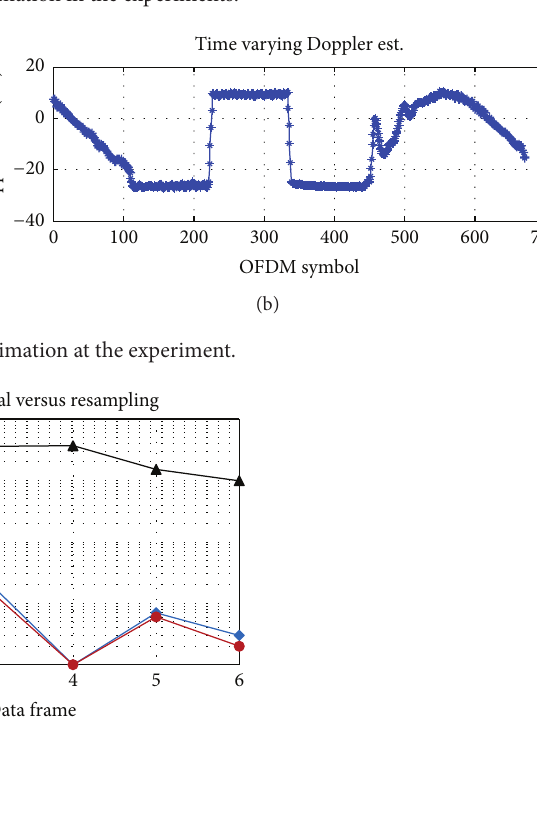
Figure 13: 16QAM, Doppler estimation in the experiments.